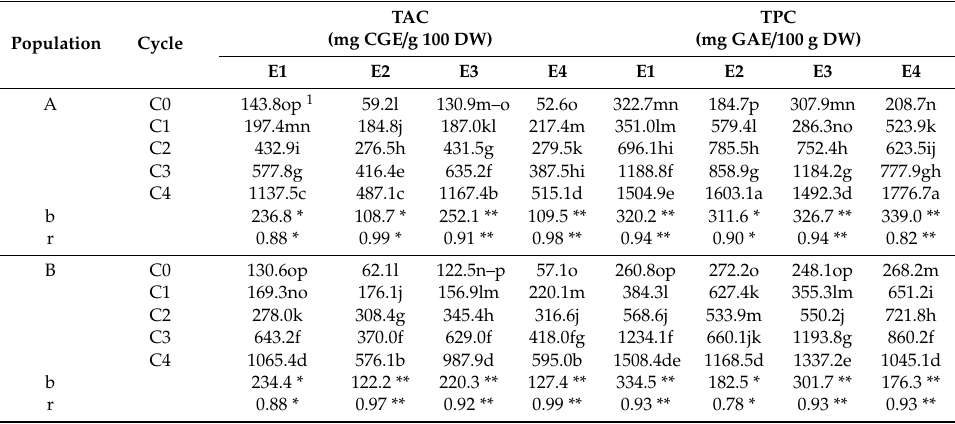
Table A7. Means for total anthocyanin content (TAC), total phenolic content (TPC) of (A–E) five populations and (C0–C4) five cycles in cob evaluated in four